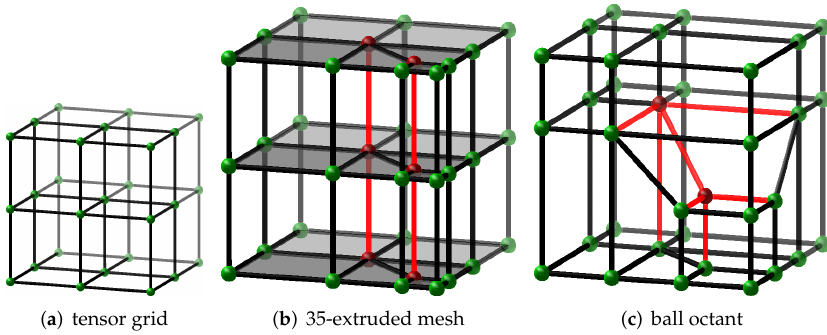
Figure 4. The three main test